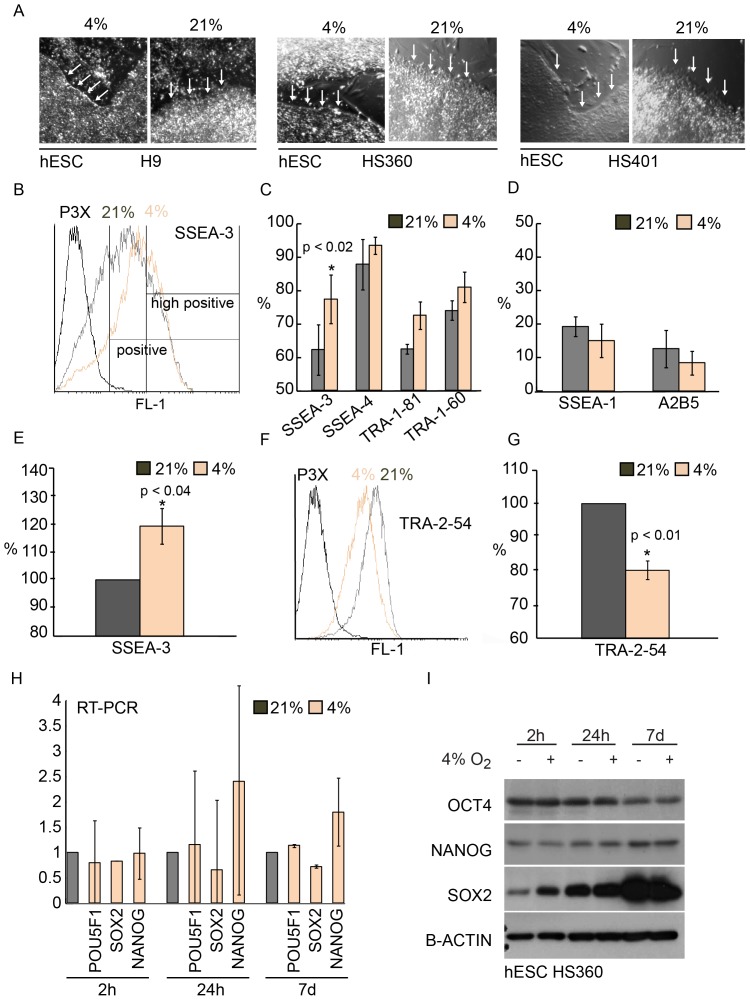
Morphology and expression of pluripotency markers.A) Morphology of hypoxia (4%) and normoxia (21%) cultured colonies after 7 days of culture for each hESC line (H9, HS360 and HS401) respectively. B–G) Flow cytometry analysis performed after 7 day culture. B) A histogram showing SSEA-3 positive cells in hypoxia and normoxia versus negative control P3X and gating example for positive and high positive populations. C) Proportion of positive cells expressing pluripotency surface antigens SSEA-3, SSEA-4, TRA-1-81, and TRA-1-60. D) Proportion of positive cells expressing differentiation surface antigens SSEA-1 and A2B5. E) Proportion of high positive cells expressing SSEA-3. F) Histogram of TRA-2-54 expressing cells. G) Proportion of high positive cells expressing TRA-2-54 (alkaline phosphatase). H) Real-time PCR analysis of POU5F1 (OCT4), SOX2 and NANOG in response to hypoxia (4%) over time (2 h, 24 h, and 7 d) compared to normoxia (21%). Data from two replicate cultures of hESC line H9. I) Western blot analysis of protein levels of OCT4, NANOG and SOX2 in hypoxia over time. B-ACTIN was used as a loading control.